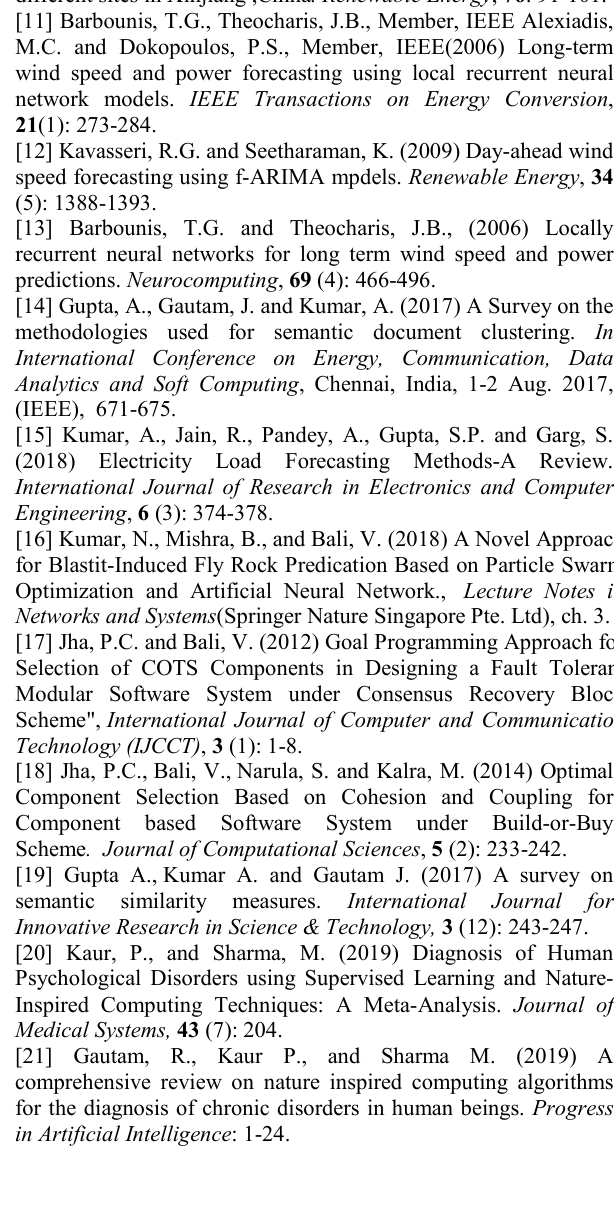
Figure 12. Performance Comparison